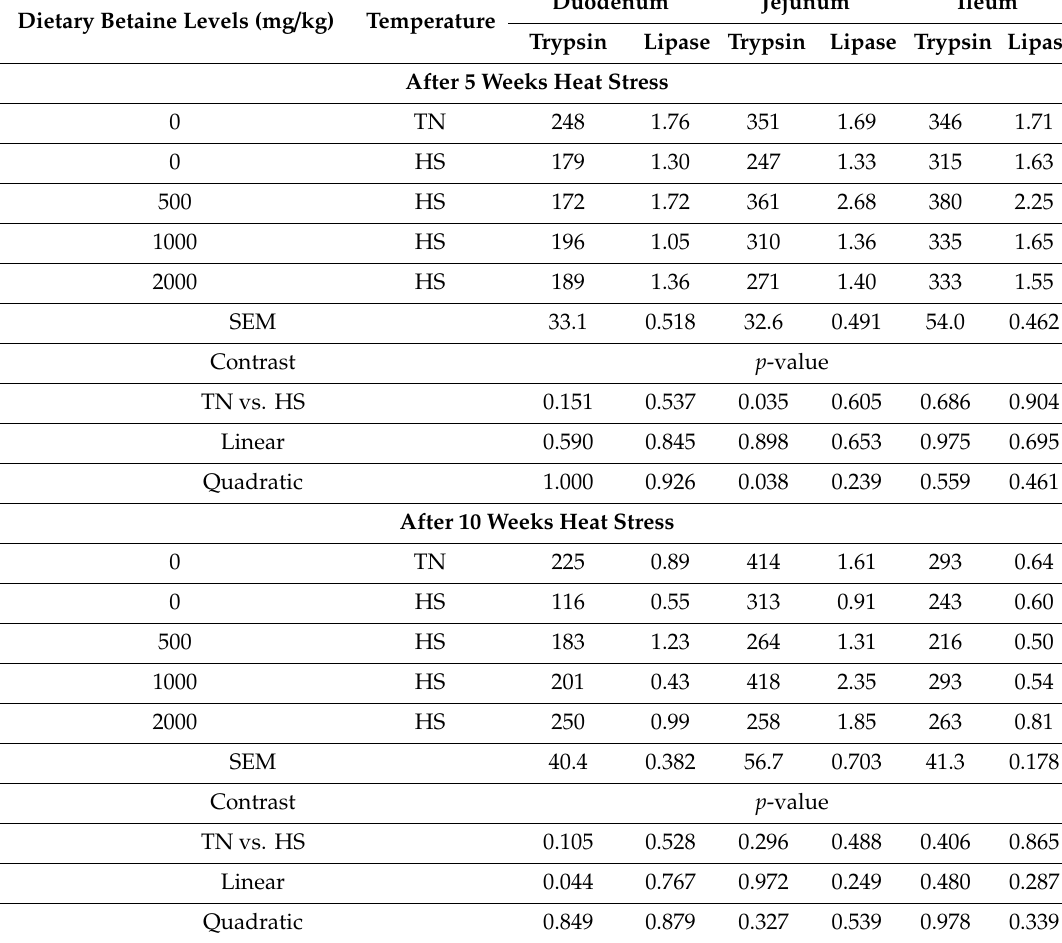
Table 4. E ff ects of heat stress and dietary betaine on digestive enzyme activity of yellow-feathered broilers*, U / mg